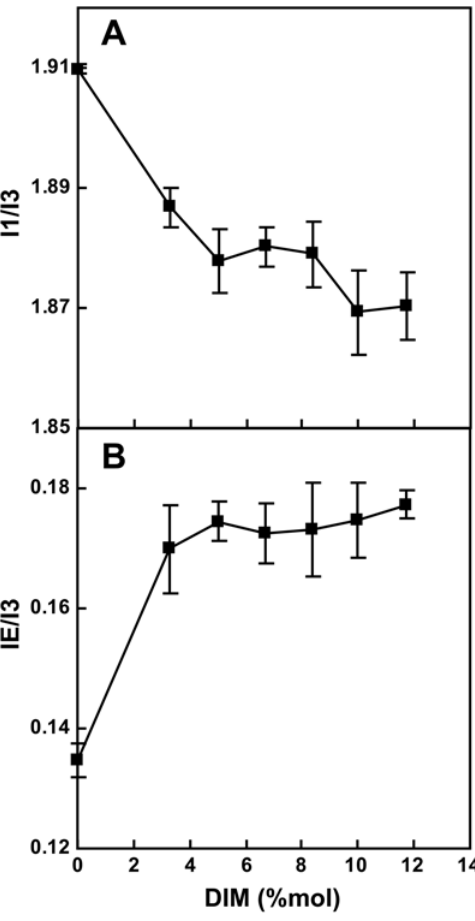
Figure 8. Insertion of DIM into model membranes decreases the polarity of the bilayer core by modifying membrane structure. DIM were incorporated into LUVs containing 1 mol% of Py-met-chol. Changes in the I 1 / I 3 (A) and I E / I 3 (B) fluorescence ratios of Py-met-chol in LUVs were examined as a function of DIM mole fraction. Measurements were performed in the fluid state, at 45 u C. Data are means 6 SD of three independent experiments.